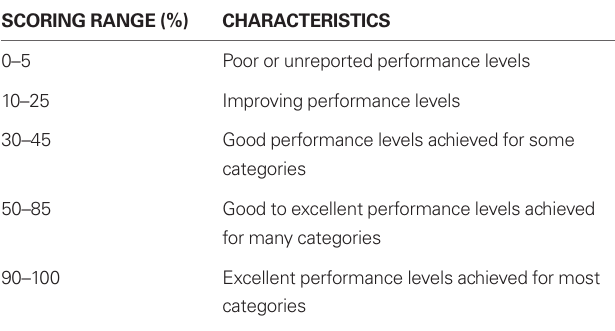
Table 4 | results scoring (category